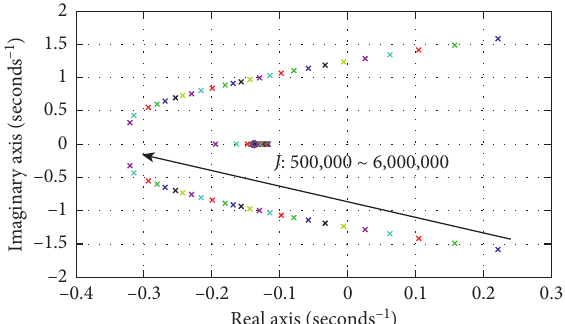
Figure 10: Effect of rotary inertia on Speed Response.